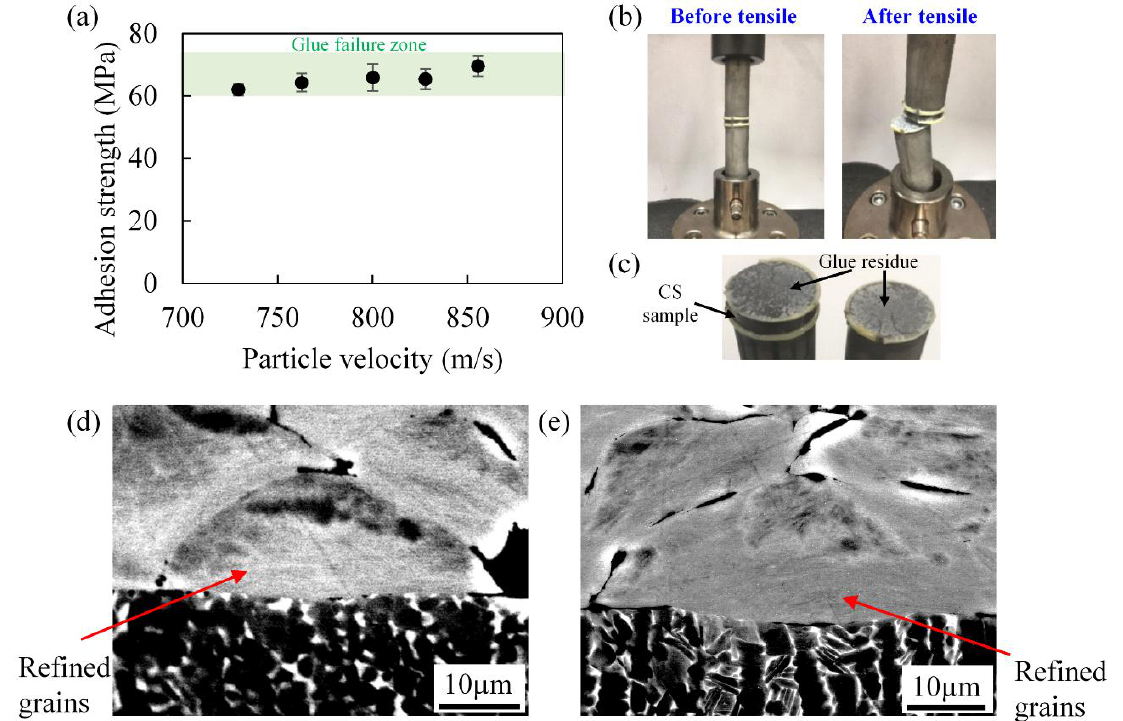
Figure 8. ( a ) Coating adhesion strength as a function of particle exit velocity; ( b ) photographs of a coated sample before and after tensile test; ( c ) photograph of the coated sample which shows glue failure, and ( d , e ) back-scattered SEM micrographs of particles impacted with velocities of ( d ) 730 and ( e ) 800